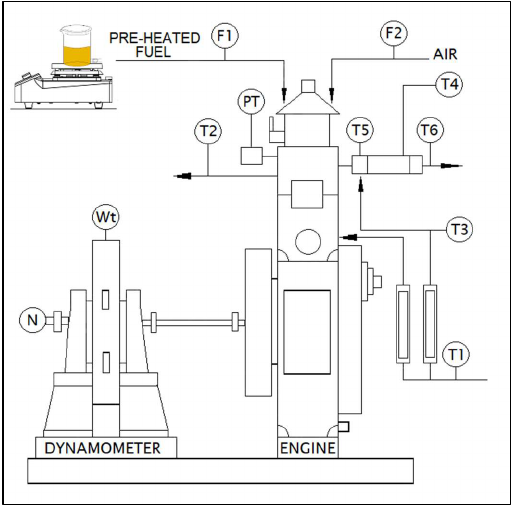
Figure 2. A 2D representation of test engine setup. Source: Apex Innovations Private Limited (Maharashtra, India). Table 1. Technical specifications of Kirloskar TV1 Engine and AVL DI GAS 444 N Flue Gas Ana- lyzer [35].